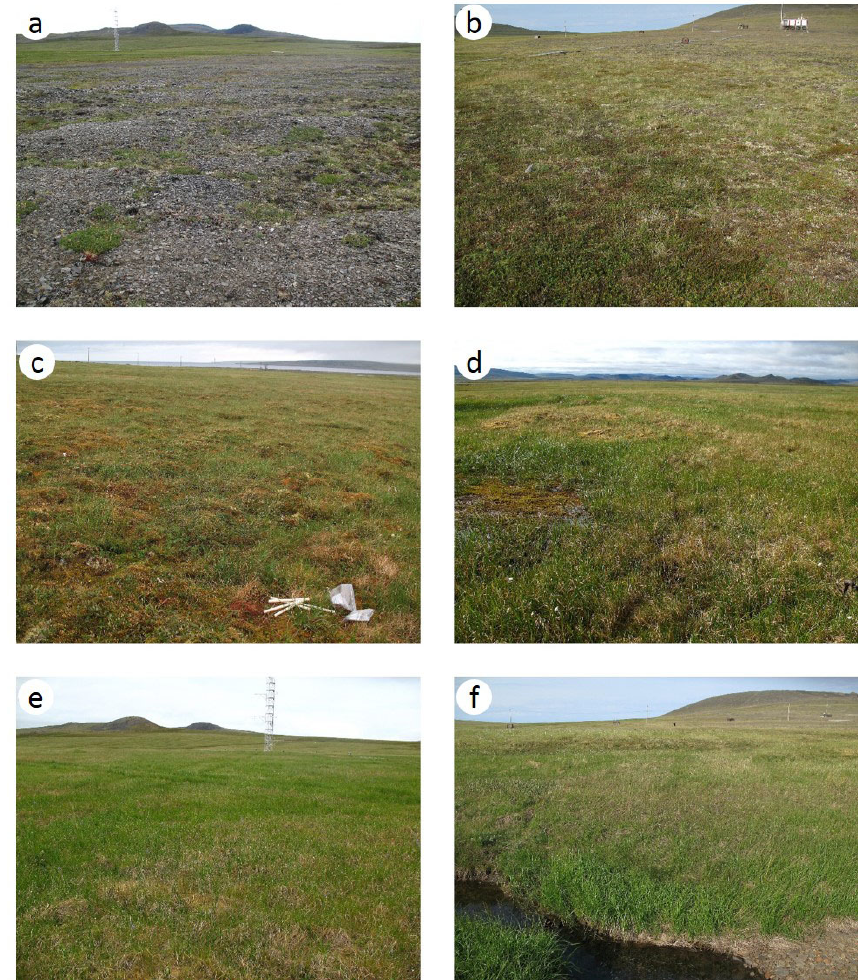
Figure 3. Land cover types of the study area: (a) bare soil with lichen tundra patches, (b) shrub tundra in the foreground and lichen tundra in the background, (c) bog, (d) mixture of dry and wet fen, (e) graminoid tundra, and (f) stream and flood